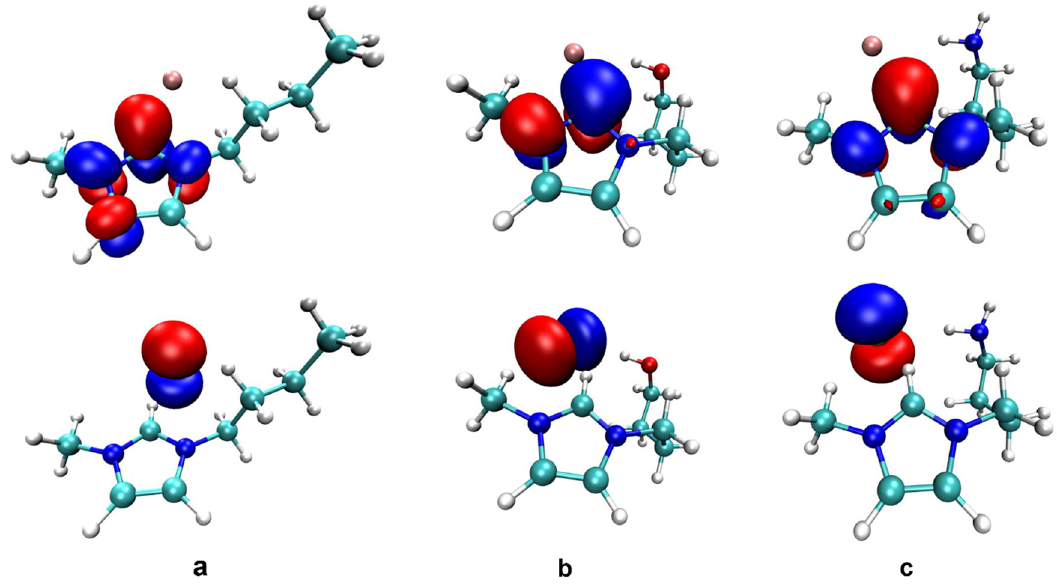
Figure 3: HOMO ( lower ) and LUMO ( upper ) orbital plots at the B3LYP/6 - 311 ++ G ( d, p ) level: ( a ) C 4 mimBr, ( b ) C 4 OHmimBr, and ( c ) C 4 NH 2 mimBr